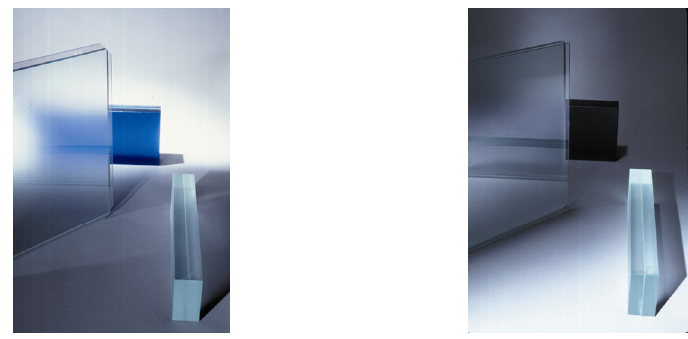
Figure 2: view from the gallery of the “Retracting Screen” as it descends into the floor.